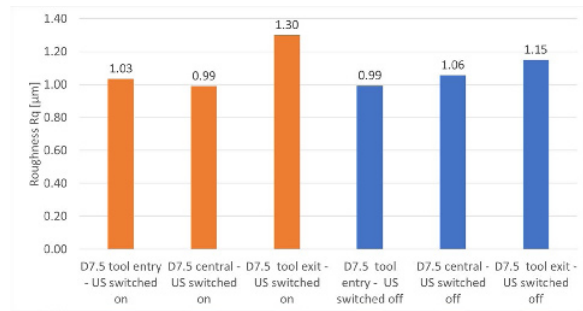
Fig. 3. Roughness results for the 7.5 mm diameter